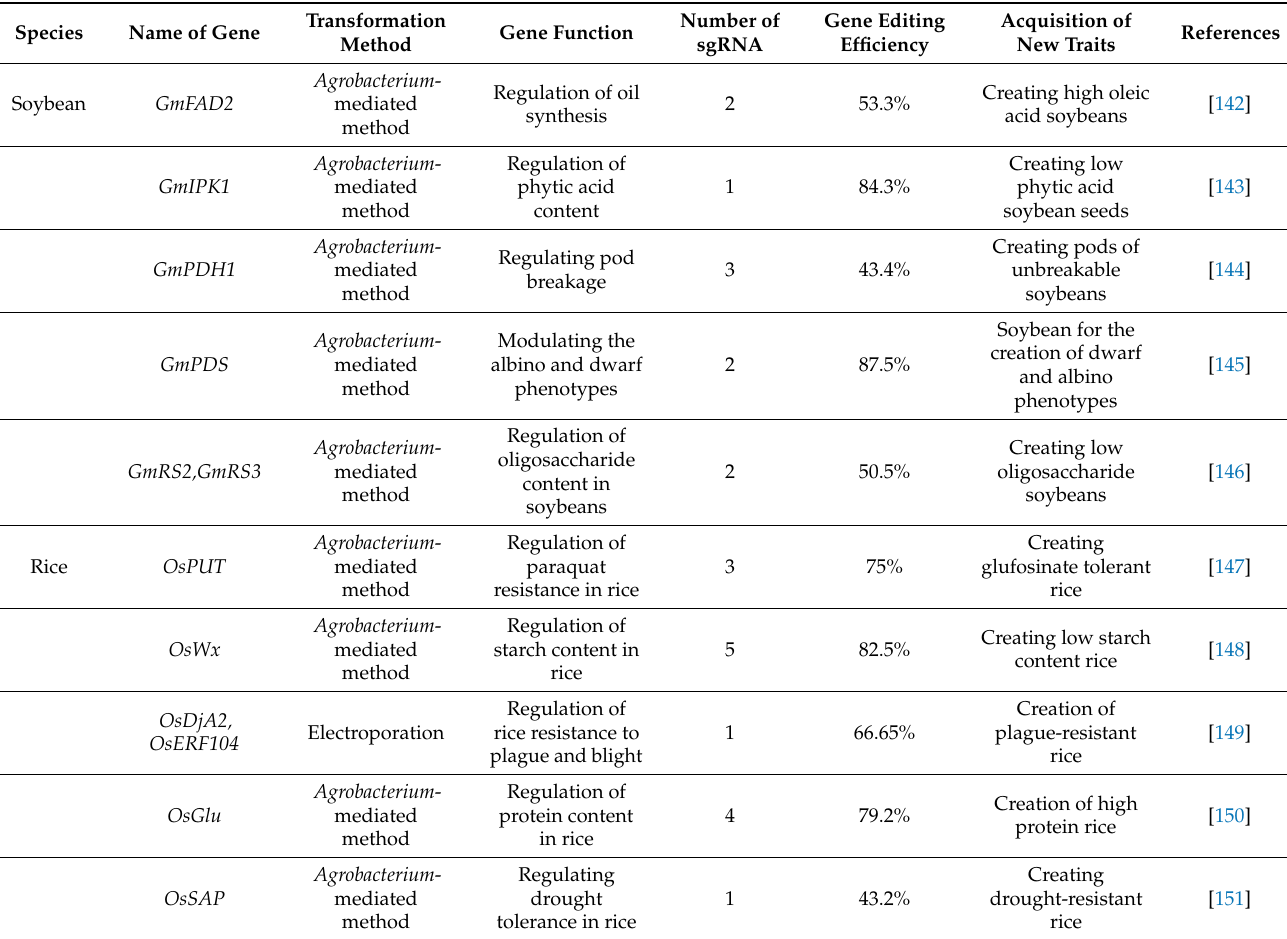
Table 2. CRISPR/Cas9-targeted genes and editing efficiency in major agricultural